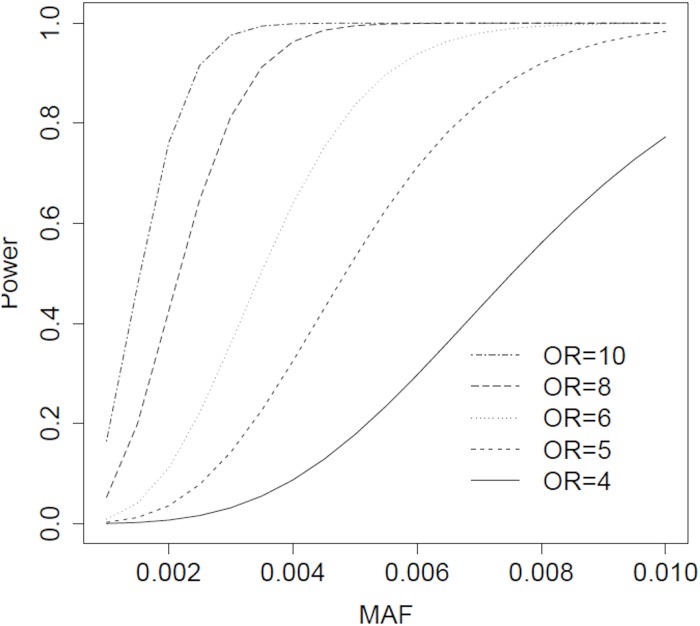
Power calculation.Post-hoc power calculations to identify a single variant associated with statin-related myopathy in primary analysis population given effect size (odds ratio) and minor allele frequency (MAF), α = 0.05 / 162,813.